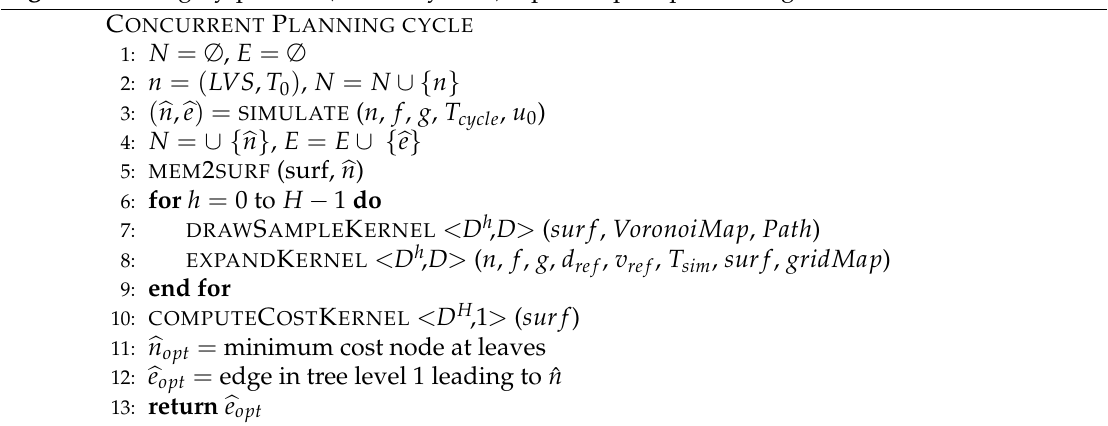
Algorithm 2 Highly-parallel (i.e., many-core) top-level path planner algorithm. C ONCURRENT P LANNING